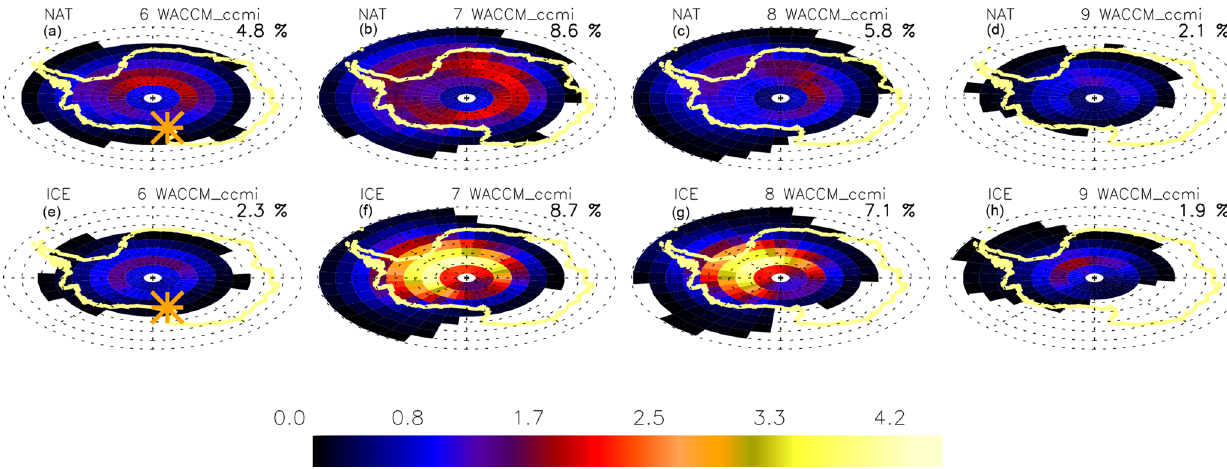
Figure 10. WACCM-CCMI PSCs vertical extent (in km) for NAT and ice, averaged over 5 years during the months of June, July, August and September (left to right). In the left column, the location of McMurdo is indicated with a yellow asterisk. The fraction of the overall air volume (between 12 and 30km height south of 60 ◦ S) occupied by different PSC classes for each month is reported in the top-right corner.